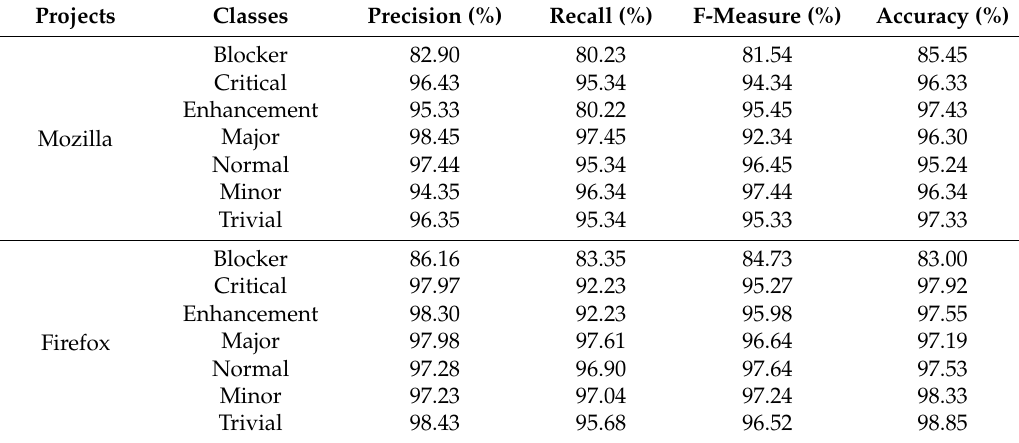
Table 2. Analysis of the proposed BCR model on five